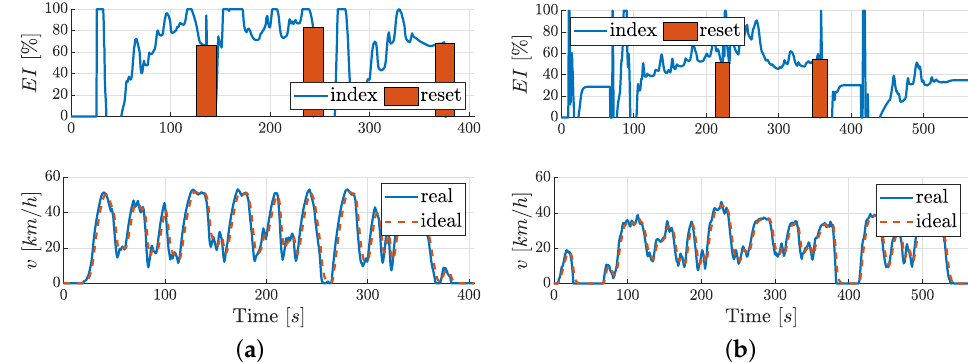
Figure 19. Eco Index and real/ideal speed profiles, for two urban driving tests, an aggressive one (upper plot), and a not-aggressive one (lower plot). ( a ) Aggressive driving. ( b ) Calm driving.